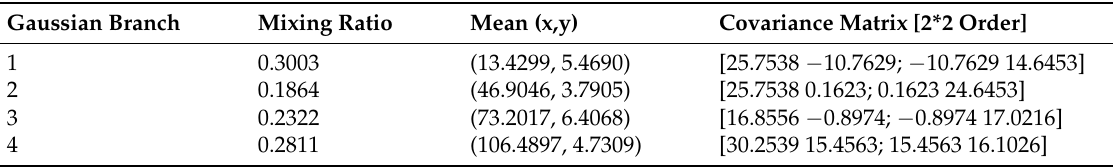
Table 5. Gaussian mixture model parameter estimation